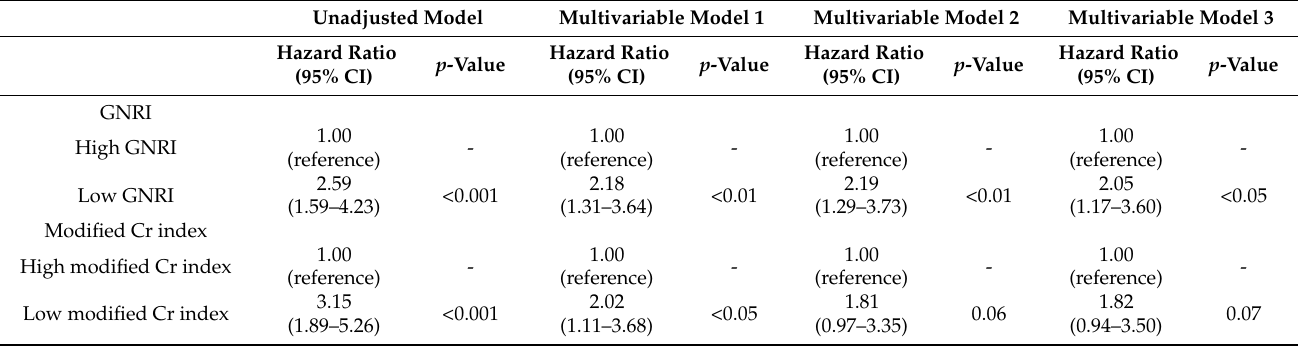
Figure 1. Five-year survival stratified by GNRI ( A ), modified Cr index ( B ), and a combination of both ( C ). Cr, creatinine; GNRI, geriatric nutritional risk index. Table 2. Prognostic impacts of each